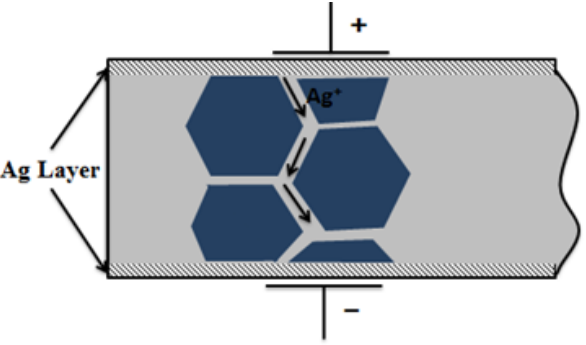
Figure 6: Shows the schematic diagram of Ag-ion